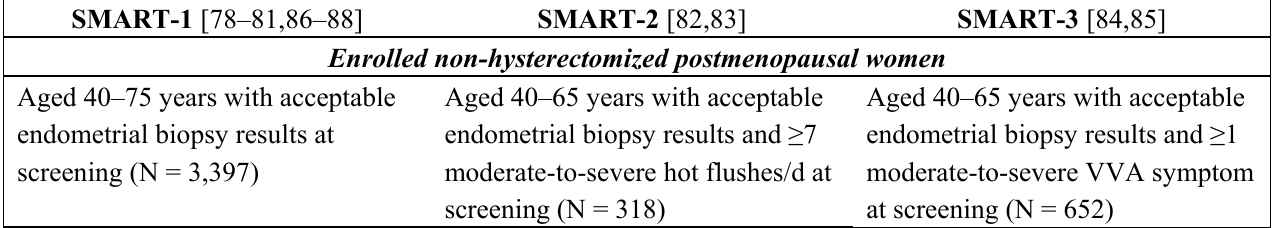
Table 2. Summary of the SMART trial study